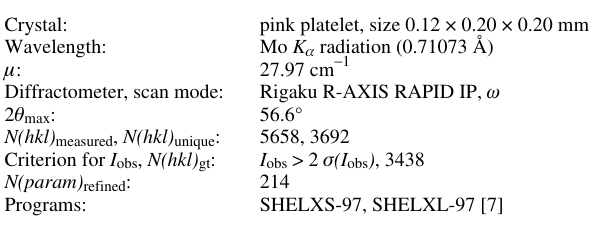
Table 1. Data collection and handling.